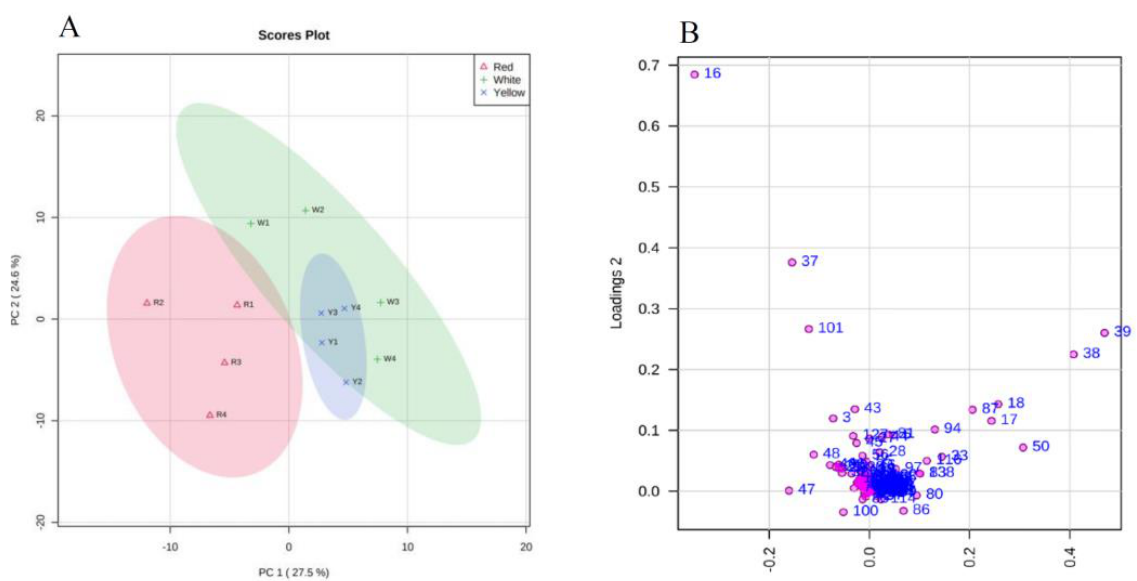
Figure 5. Principal component analysis of fruiting bodies of different A. cinnamomea phenotypes. ( A ): Score plot; Component 1 = 27.5%; component 2 = 24.6%. Different color represents different AC phenotypes as indicated in the legend. ( B ): Principal component analysis (PCA)-derived loading plot of the two principal components (PC1 and PC2) of 140 metabolites from different AC pheno- types.